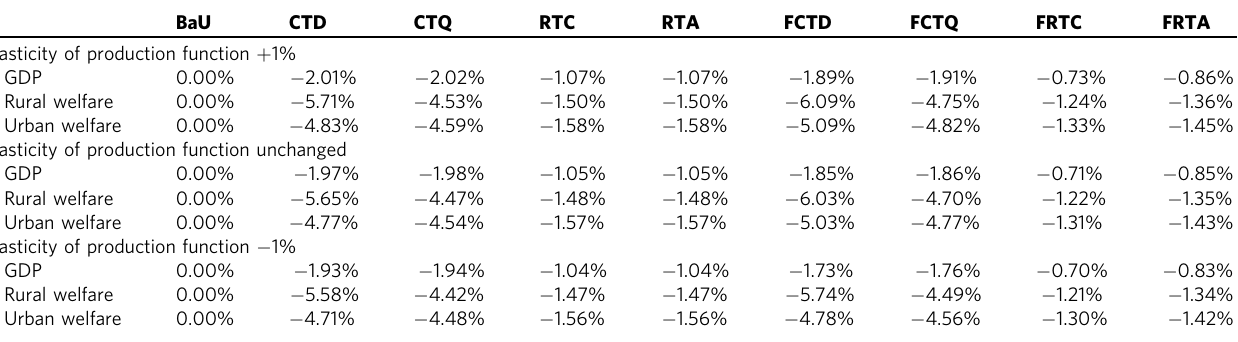
Table 4 Sensitivity